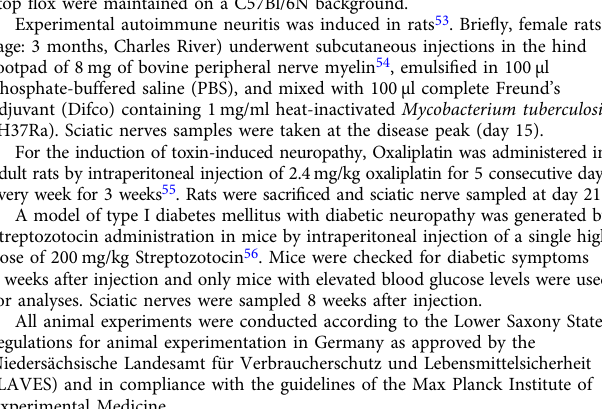
Fig. 6 Neuregulin-1 type 1 (NRG1-I) induced interaction between Schwann cells mediates onion bulb formation. a Representative electron micrographs of sciatic nerve cross-sections 4 weeks post crush (4wpc) in a mouse overexpressing glial NRG1-I (middle panel with blow up of an onion bulb structure)